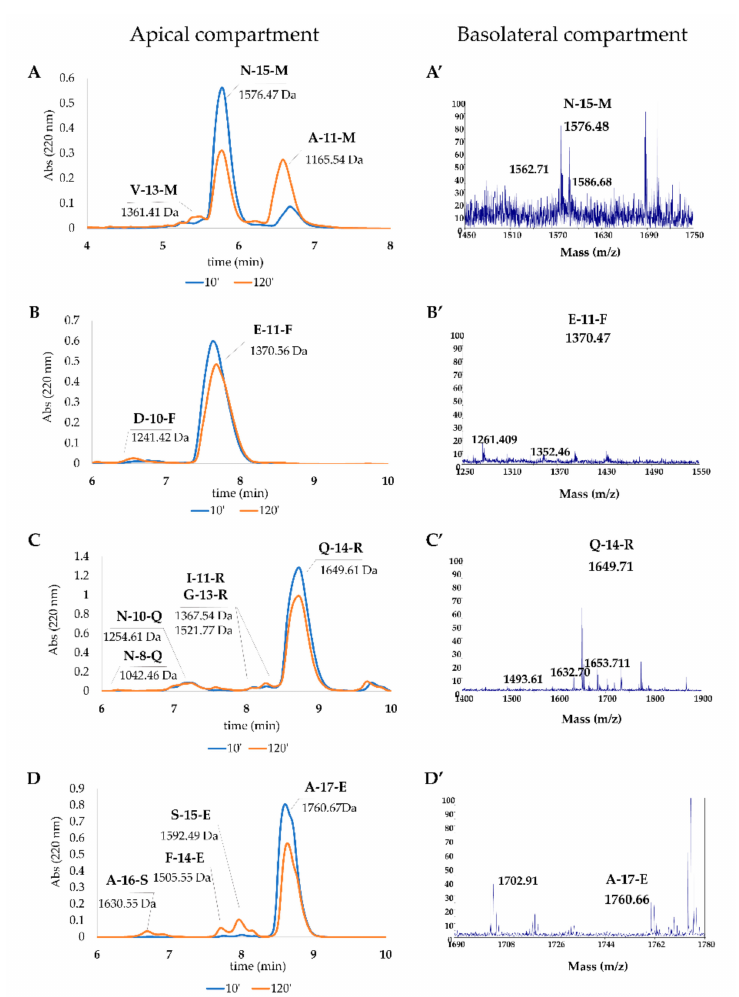
Figure 8. Uptake of the peptides by Caco-2 cells monolayer and their detection in AP and BL compartments. Each peptide (75 µ g) was administered to the monolayer cells and samples of AP and BL were collected at the indicated time. ( A–D ) RP-HPLC chromatograms of the four peptides in the apical compartment at 10 and 120 min. ( A’–D’ ) MS analysis of the peptides present in the basolateral side after 120